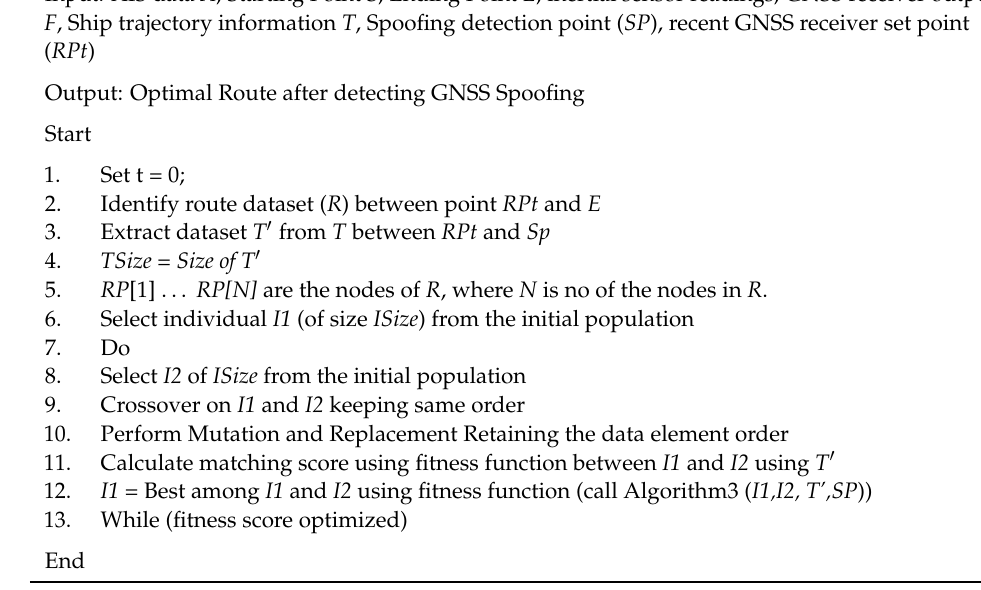
Algorithm 1 GNSS Spoofing Mitigation